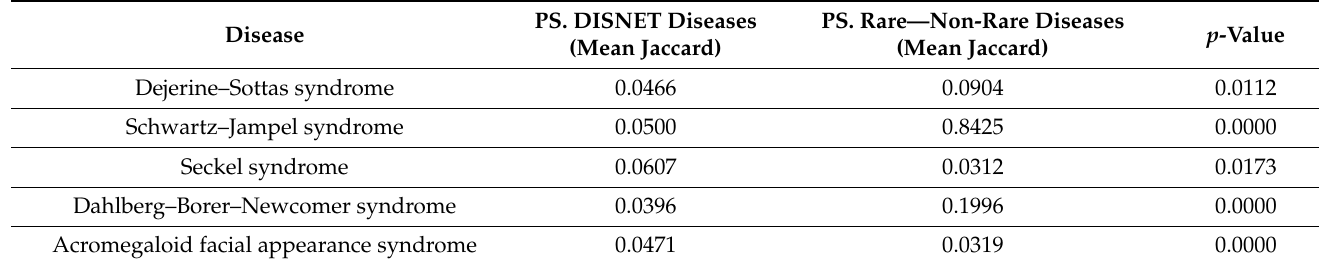
Table 4. Results of the phenotypic similarity comparison between rare and non-rare diseases with potential drugs versus DISNET disease